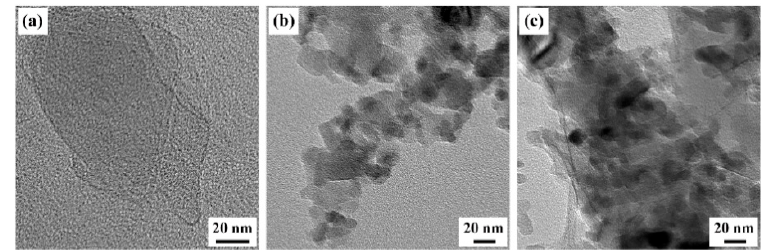
Figure 2. TEM images of ( a ) rGO, ( b ) Al 2 O 3 and ( c ) rGO-Al 2 O 3 nanoparticles.